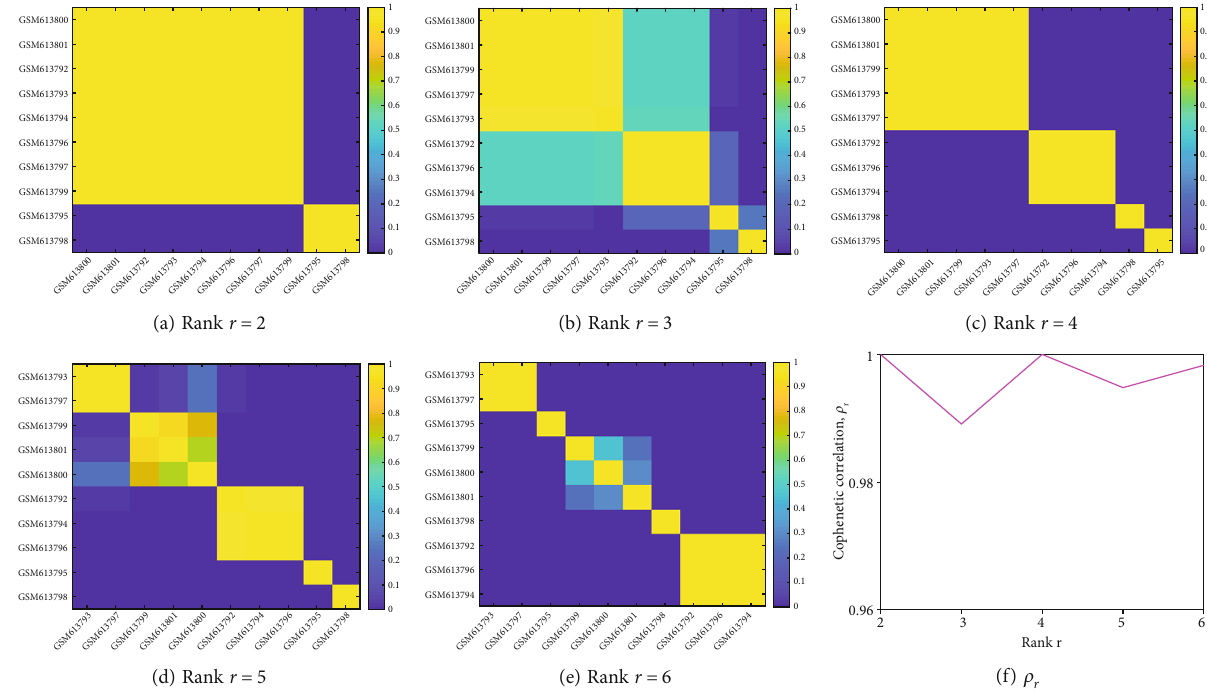
r = 2 ‐ 6 using MM. r for